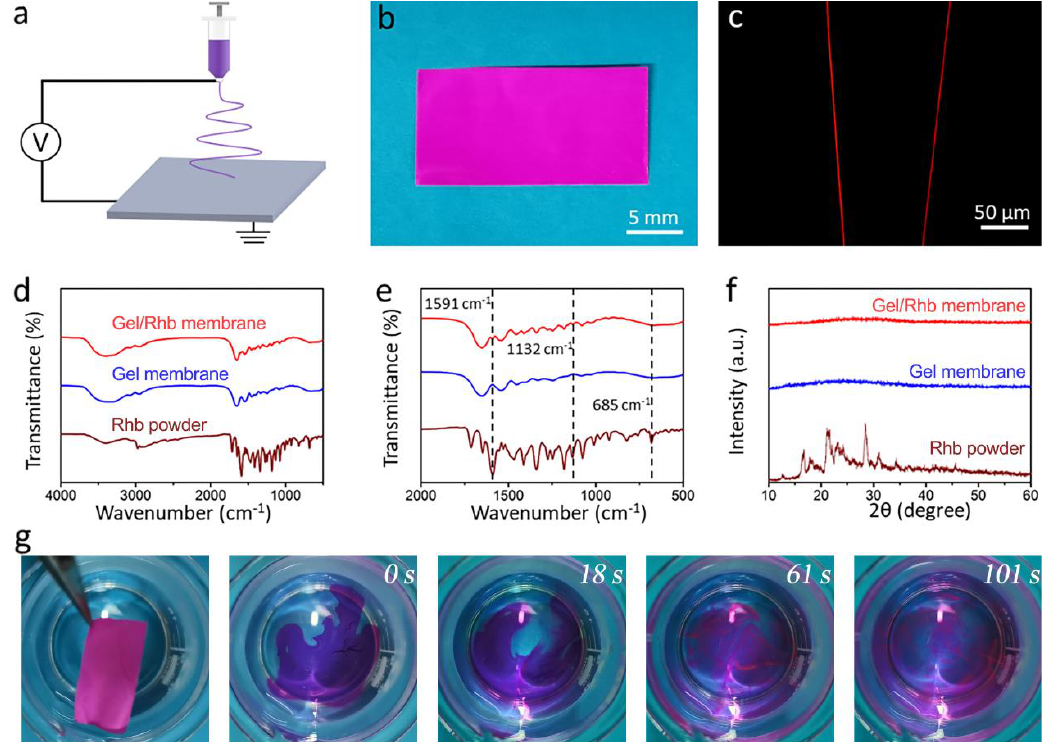
Figure 2. ( a ) Schematic illustration of the process of fabricating of Gel/Rhb membrane by elec- trspinning. ( b ) Optical image exhibiting the red appearance of the Gel/Rhb membrane. ( c ) Image of the Gel/Rhb nanofibers from fluorescence microscopy. ( d ) FTIR spectra and ( e ) partial enlarged FTIR spectra. ( f ) XRD patterns of Rhb powder, pristine Gel membrane, and Gel/Rhb membrane. ( g ) Fast dissolution process of the Gel/Rhb membrane.